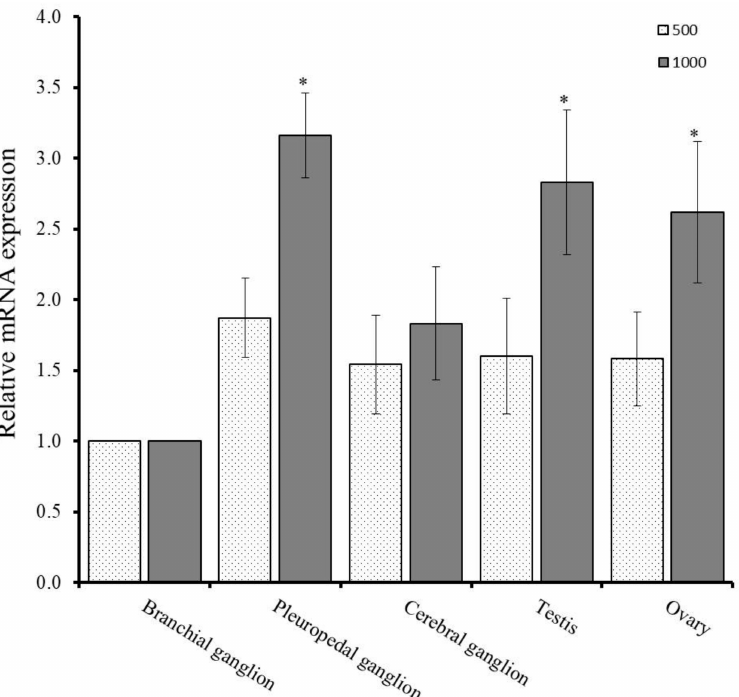
Figure 6. Expression levels of GnRH-R mRNA at di ff erent e ff ective accumulative temperature (EAT) in neural ganglia and gonadal tissues as determined by qPCR assay. Data were compared with the value of the branchial ganglion, which was assigned a relative value of 1. Asterisks indicate significant di ff erences ( p ≤